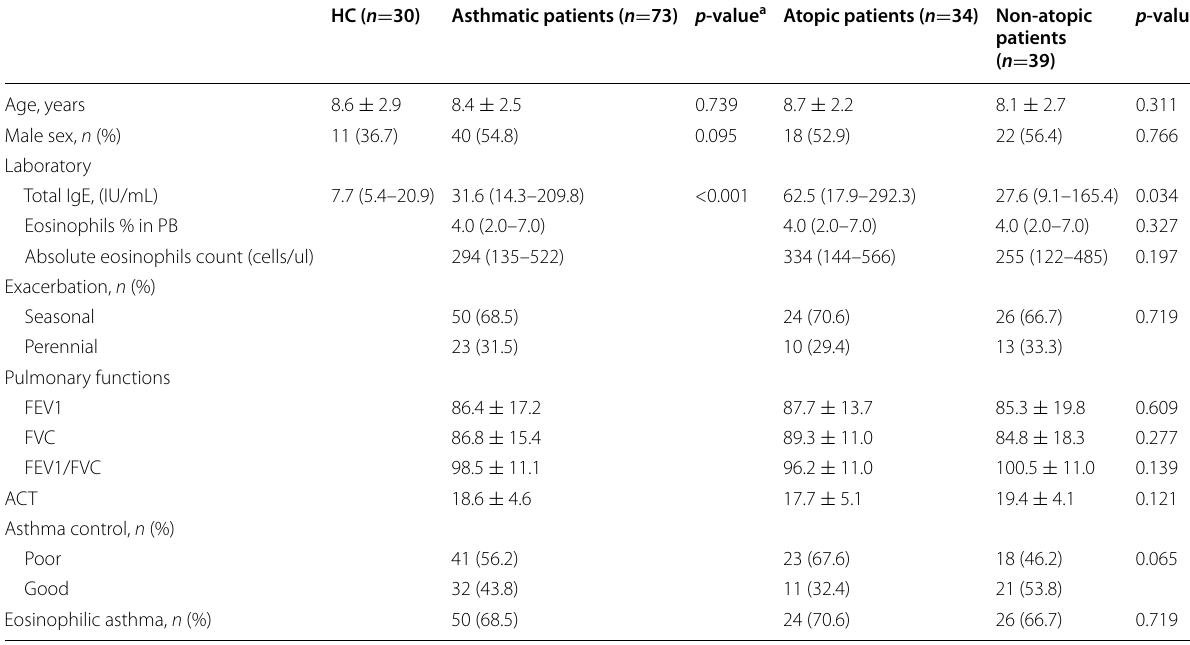
Variables with normal distribution are presented as mean standard deviation. Skewed variables are presented as median (interquartile range) ± HC healthy controls; IgE immunoglobulin E; PB peripheral blood; FEV1 forced expiratory volume in 1st second; FVC forced vital capacity; ACT asthma control test a p value of asthmatic patients vs healthy control b p value of atopic vs non-atopic asthmatic patients